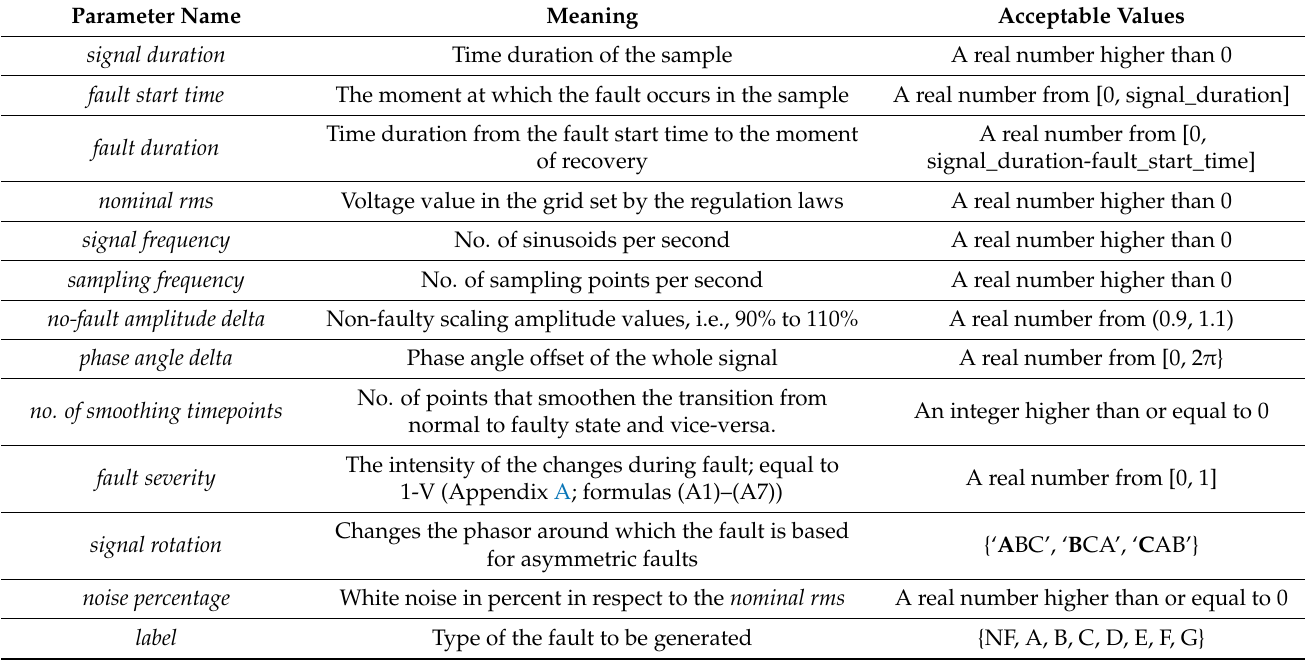
Table 1. The list of generator parameters with their meanings and acceptable